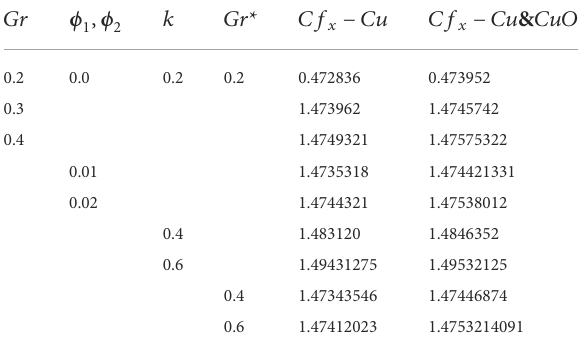
TABLE 2 C fx Re 0 . 5 x numerical outcomes versus different values of emerging parameters.